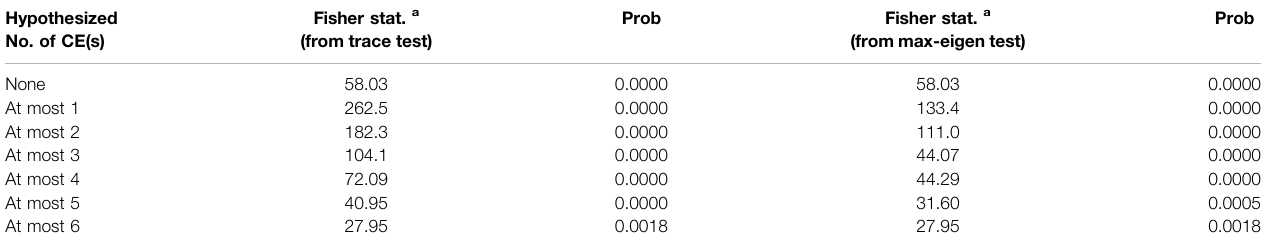
TABLE 5 | Fisher panel Johansen co-integration test results. Hypothesized No. of CE(s)